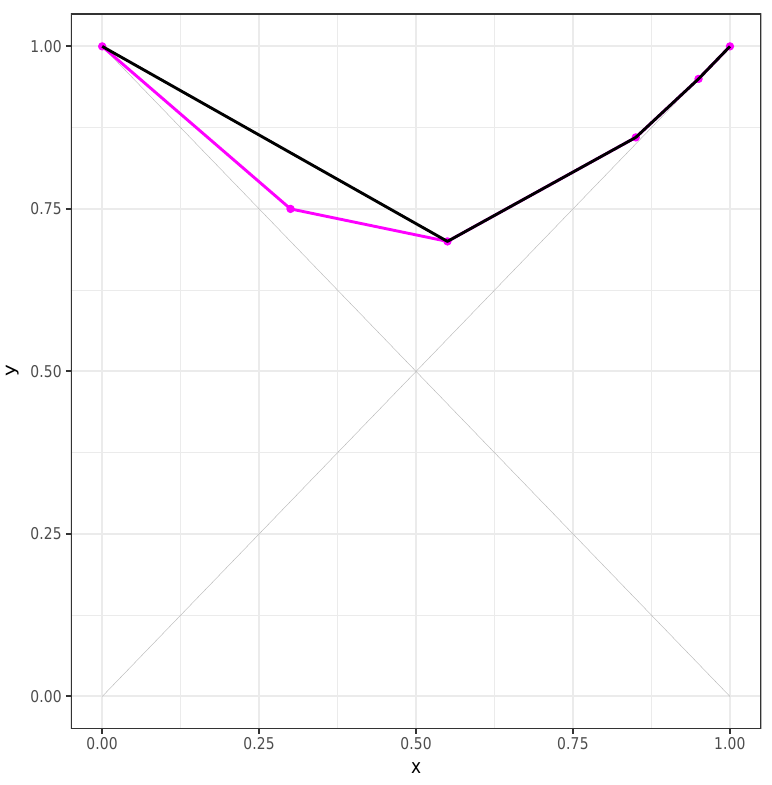
Figure 1: Example of a Pickands dependence function A ∈ A x with x = (0.55, 0.85, 0.95) (black) and the Pickands function φ x x , y ( A ) with x = 0.3, y = 0.75